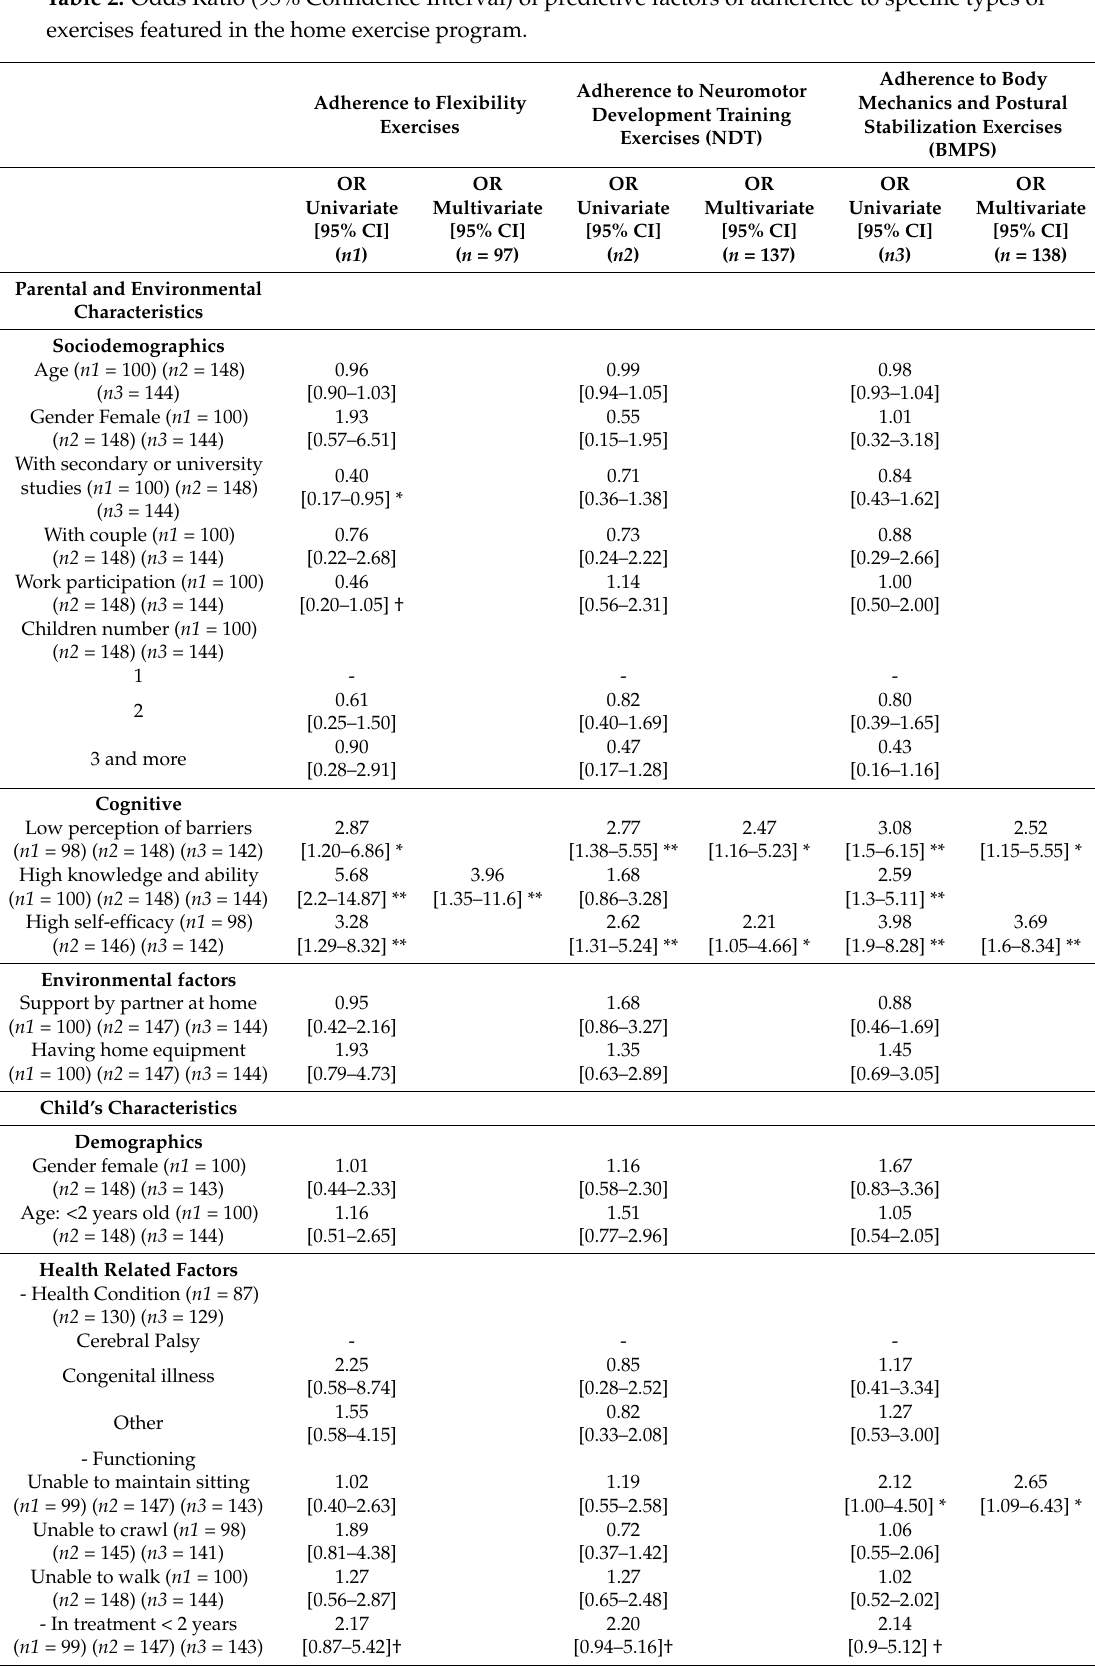
Table 2. Odds Ratio (95% Confidence Interval) of predictive factors of adherence to specific types of exercises featured in the home exercise